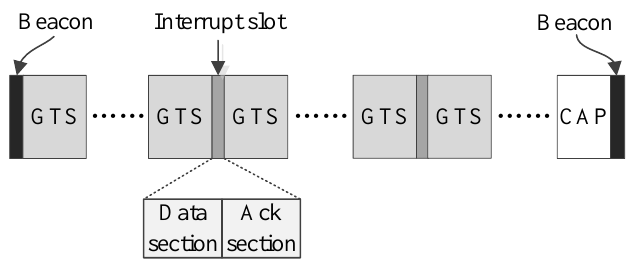
Figure 1. Structure of the I-MAC